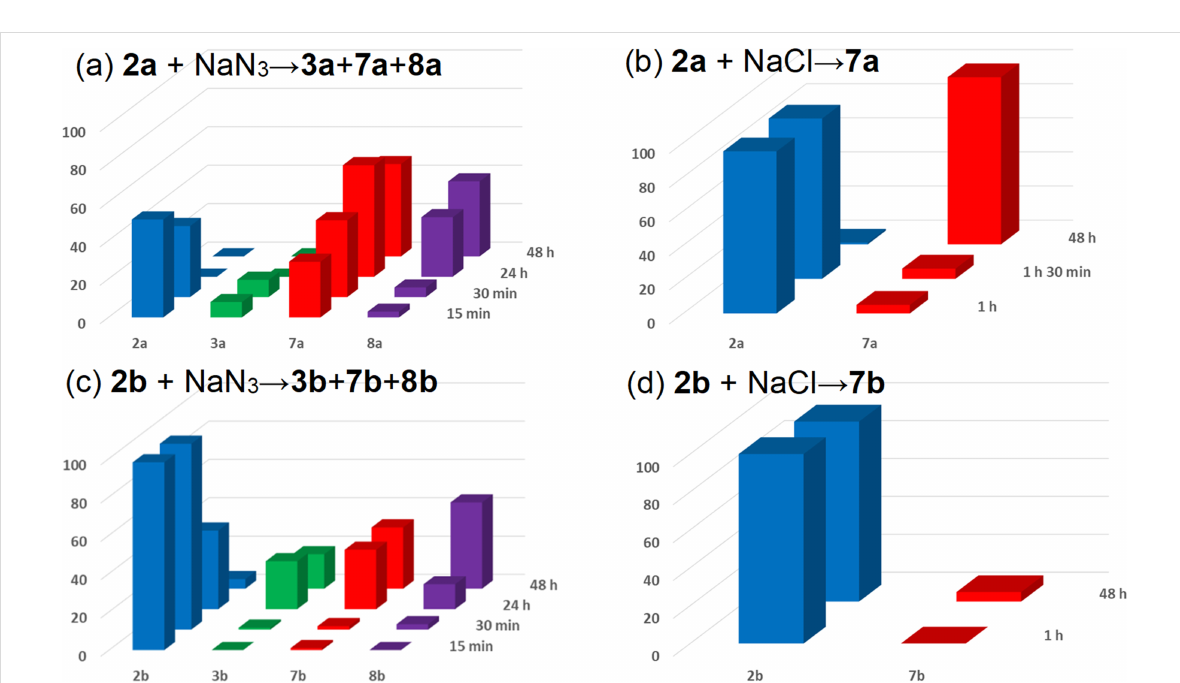
Figure 1: Screenings of the rate for the ester group cleavage (conversion determined by NMR spectroscopy) in the reactions between dialkyl (2-chloro-9-heptyl-9 H -purin-6-yl)phosphonates 2a and 2b , respectively, with NaN 3 (a, c) and NaCl (b, d). Reaction conditions: DMSO- d 6 , 90 °C.